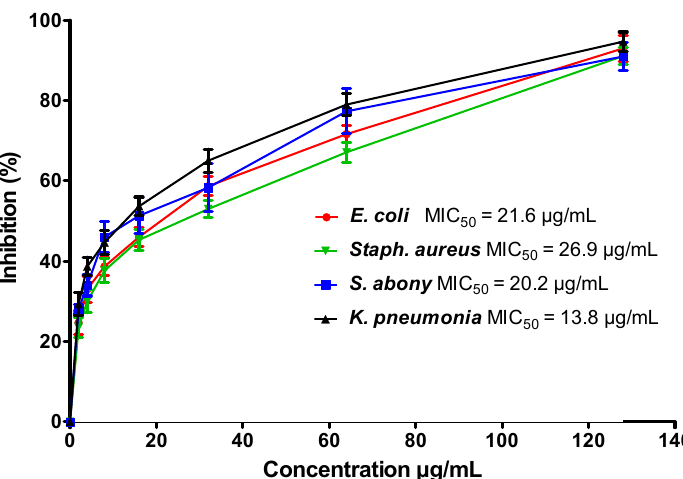
Figure 3. Determination of minimum inhibitory concentration (MIC) of GNPs. Aliquots of GNPs were serially diluted in 96-well microtiter plates in tryptic soy broth (TSB) medium. Aliquots (10 µ L) from prepared standard suspensions (equivalent to the 0.5 McFarland) of tested bacterial strains were added to each well. After overnight incubation at 37 °C, the bacterial cells were collected and viably counted. The experiment was repeated in triplicate and the data shown are the means ± standard errors. The MIC was the lowest concentration of GNPs that completely inhibited the bacterial growth, and MIC 50 was the GNPs concentration that inhibited 50% of the bacteria.